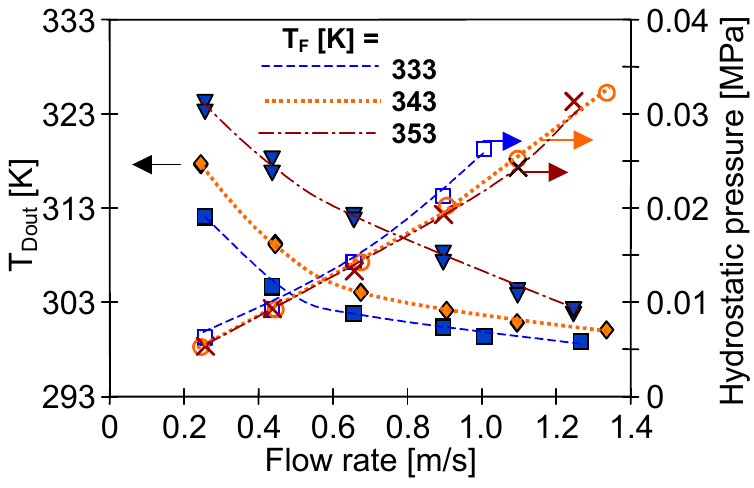
Figure 15. The influence of distillate flow rate on distillate outlet temperature and hydrostatic pressure inside capillaries. Module SMD3 (Membrane Accurel PP S6/2). Mode 1: T F = 353 K.